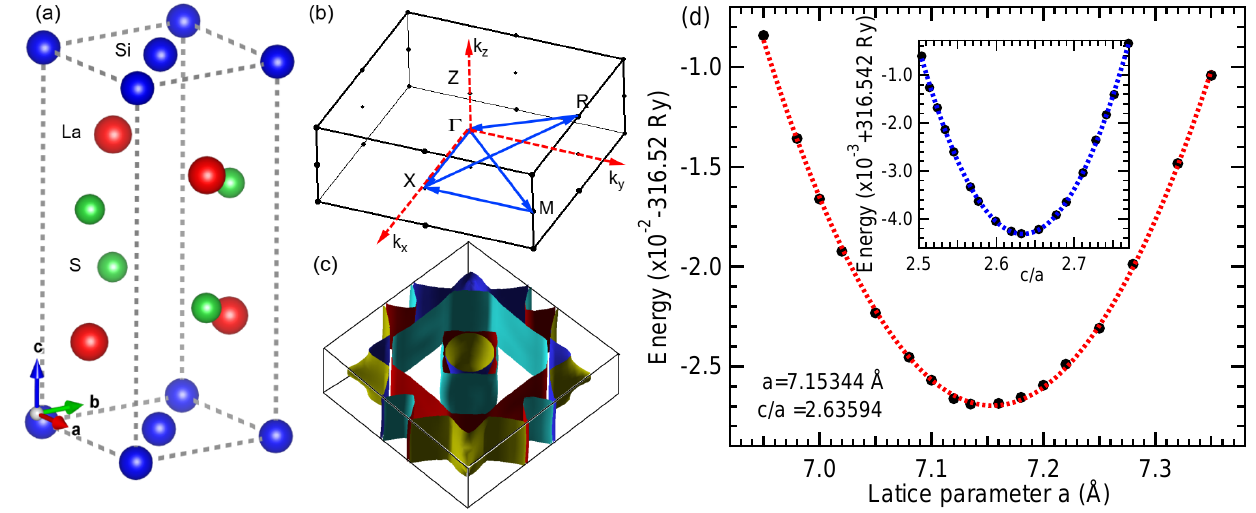
Figure 1. (Color online) Structure of bulk LaSiS. Panel ( a ): Crystal structure of LaSiS. The a , b , and c show the real space lattice vectors. The blue, red, and green solid spheres denote the Si, La, and S atoms, respectively. Panel ( b ): Bulk primitive BZ. The k x , k y , and k z show the reciprocal lattice vectors. The black dots displays the high symmetry points of the BZ with labeling Γ (0, 0, 0), M(0.5, 0.5, 0.0), X(0, 0.5, 0), R(0, 0.5, 0.5), and Z(0, 0, 0.5). Paths labeled in blue display the k-path selection for the calculations. Panel ( c ): Fermi surface of LaSiS bands. Panel ( d ): Volume optimization of LaSiS Structure. Main graph displays the volume optimization for lattice parameter a (data points represented in black solid circles and third order polynomial plot represented in red dotted lines) and the inset displays the volume optimization by choosing c / a ratio (data points represented in blue solid circles and third order polynomial fit represented in blue dotted